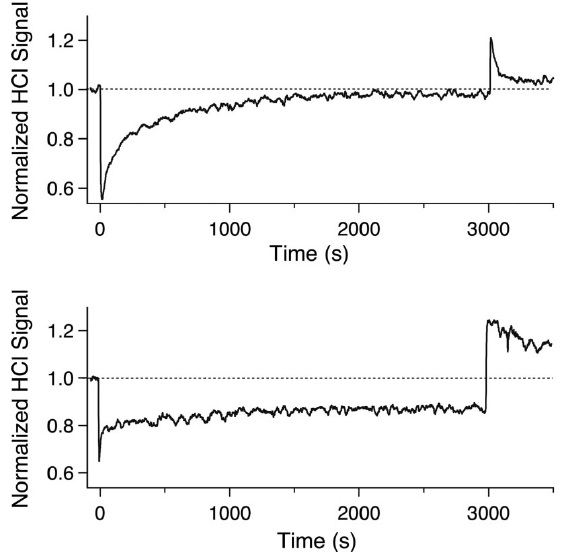
Fig. 4. HCl adsorption on zone-refined ice at % 7 & 10 ! 7 torr HCl. Shown is Fig. 10. Uptake of HCl on ice films as a function of time. Upper the HCl mass spectrometer signal (normalized to the baseline signal) vs. time. panel: Langmuir-type adsorption at 214K with a surface coverage ( Upper ) At 214 K (nondisordered conditions), 20% of adsorbed HCl (total of 1 × 10 15 moleccm − 2 . Lower panel: long-lasting flux into the dis- uptake ’ 1.2 ( 0.1 & 10 15 molecules ! cm ! 2 ) is desorbed after removal of the ordered interface of 5 × 10 11 moleccm − 2 s − 1 at ∼ 196K. This ex- Fig. 3. Summary of ellipsometer–CIMS study results: the HCl–ice phase source. ( Lower ) Under disorder-inducing conditions (196 K), we observed a ample shows how changing the experimental conditions can lead diagram adapted from Molina (7). Thermodynamically stable phases are nearly constant HCl flux (5 & 10 11 molecules ! cm ! 2 ! s ! 1 ) from the surface to the shown as a function of temperature and P HCl . Ice is the stable phase under to significantly different uptake behaviour on ice, even of the same interior of the ice sample, persisting throughout the experiment ( % 1 h). After polar stratospheric conditions (circled area). Liquid refers to a liquid solution, removalofthesource, " 80%ofthemoleculestakenuparereleasedtothegas species; see text for details. Reprinted from McNeill et al. (2006). and HCl ! 3H 2 O and HCl ! 6H 2 O refer to the crystalline hydrate states. Blue phase. Copyright (2006) National Academy of Sciences, USA. squares indicate conditions where a change in signal consistent with forma- tion of a disordered region at the ice surface was observed, and red circles indicate conditions where no surface change was observed. Arrows represent constant P HCl (temperature scanning) experiments. Bars represent tempera- tures at which cease ! onset of surface changes were observed. Phase transi- tions are indicated by open triangles.